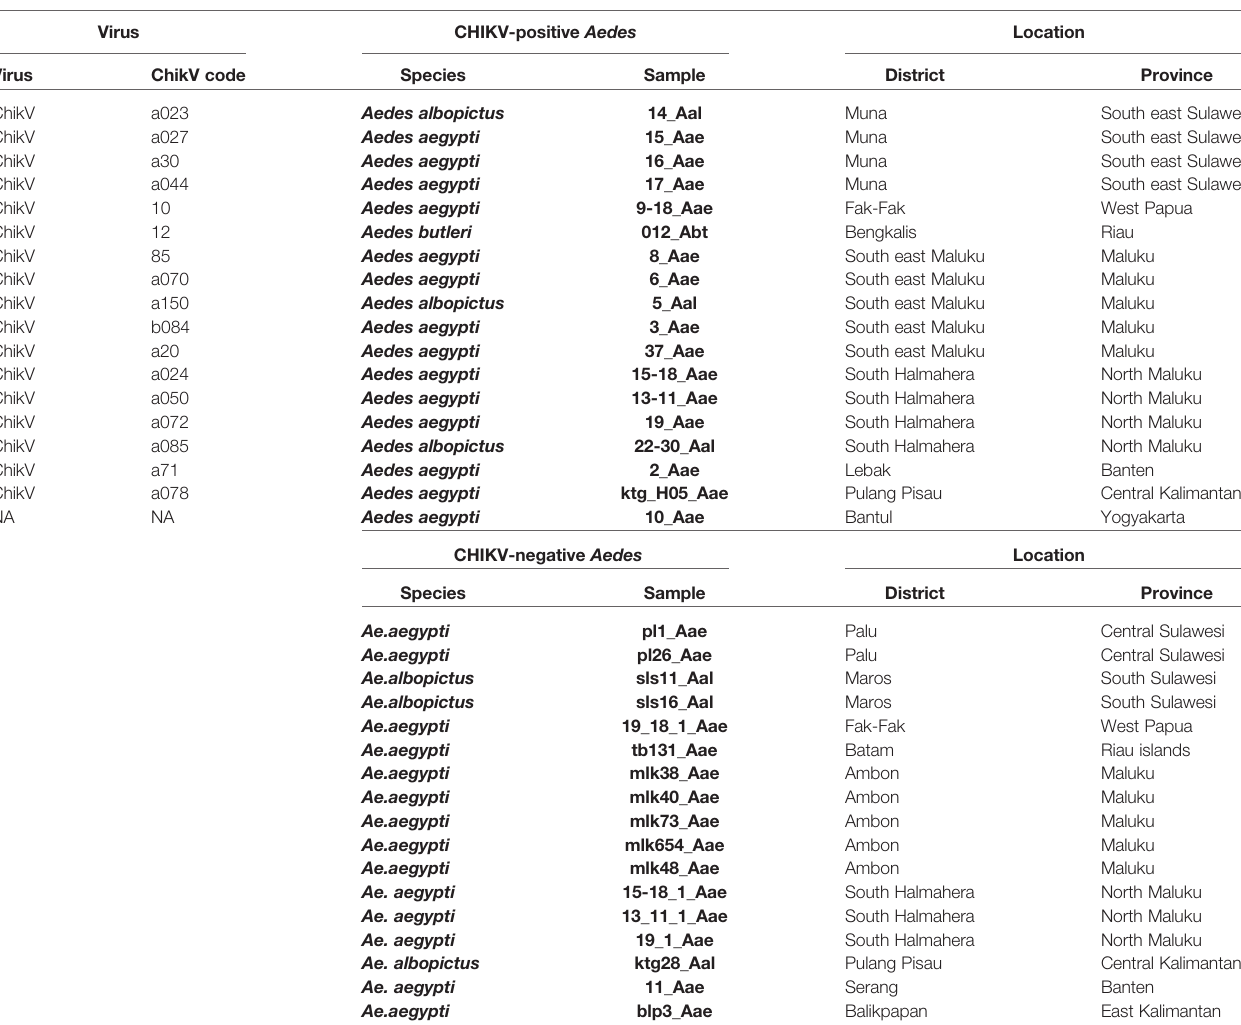
TABLE 1 | Description of the samples used for